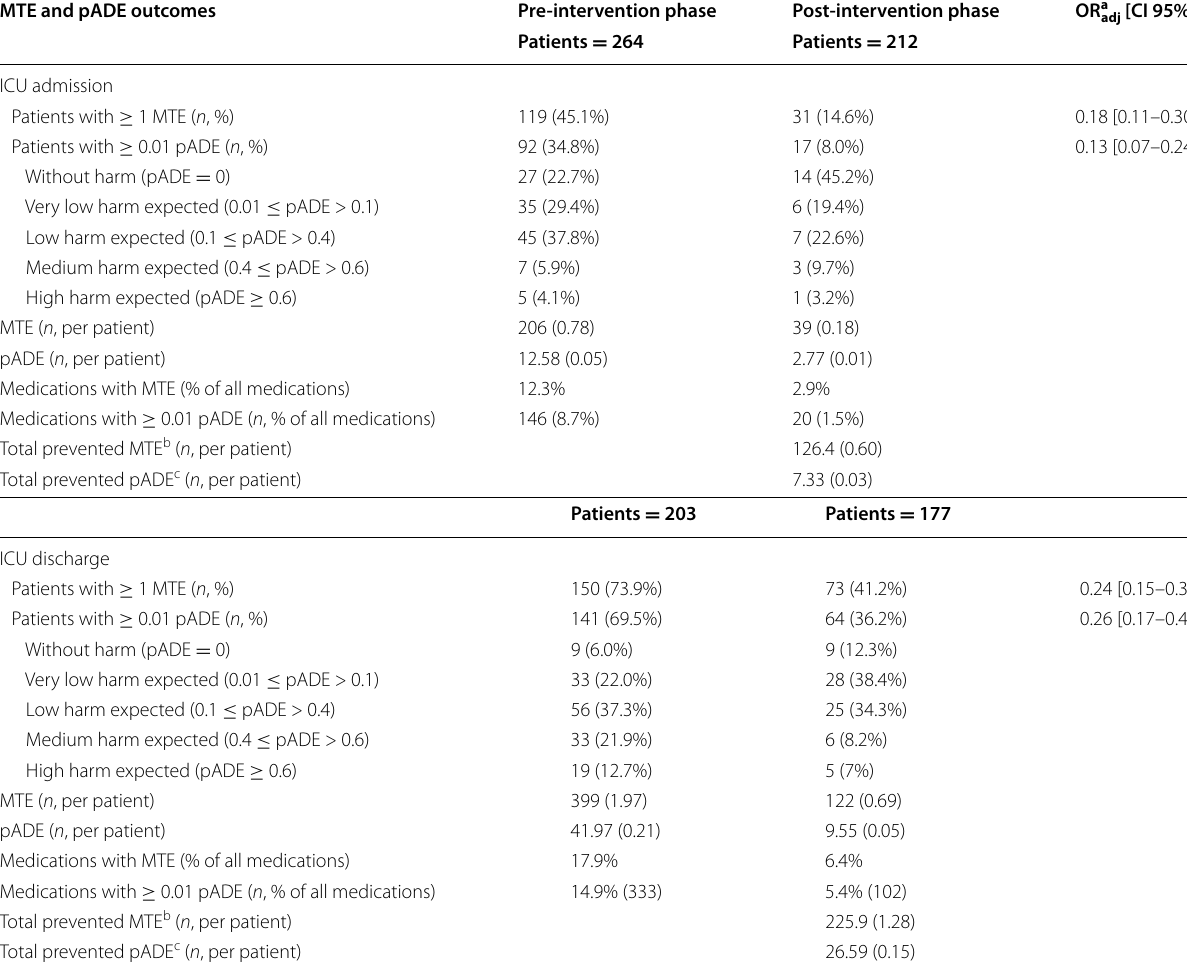
Table 4 Medication transfer errors (MTE) and potential adverse drug event (pADE)